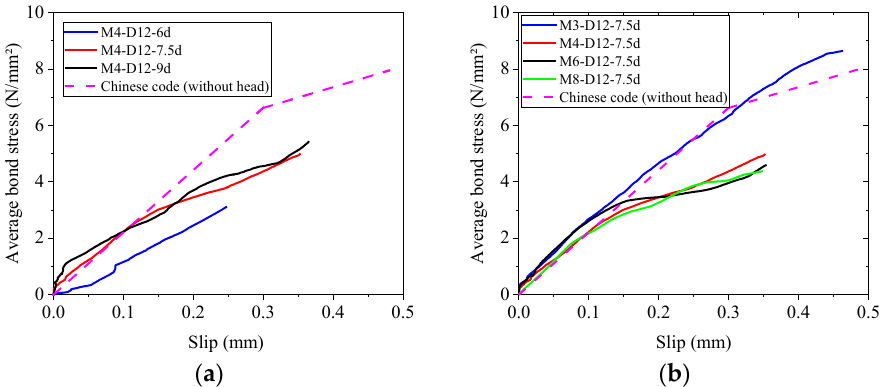
Figure 27. Average bond stress–slip curve ( a ) Comparison of different lap length; ( b ) Comparison of different head size.